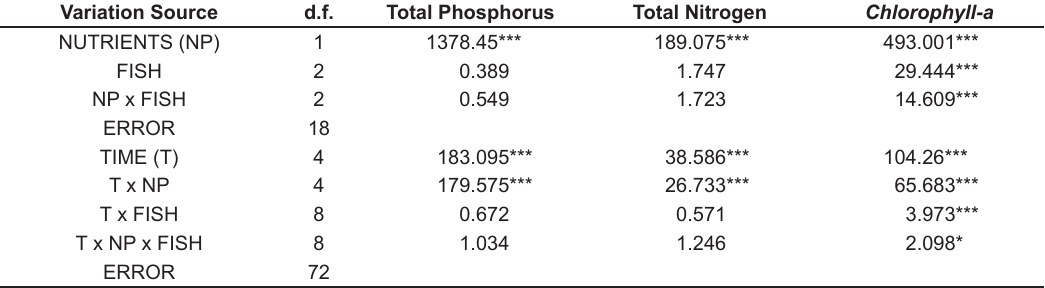
Table 1. F-values of repeated measures ANOVA for Total Phosphorus, Total Nitrogen and Chlorophyll- a measure- ments taken in all factorial combination of the following treatments: nutrients (NP), fishes (fingerlings and juvenile), and nutrients plus fishes. Mean values are represented in Figures 1, 2 and